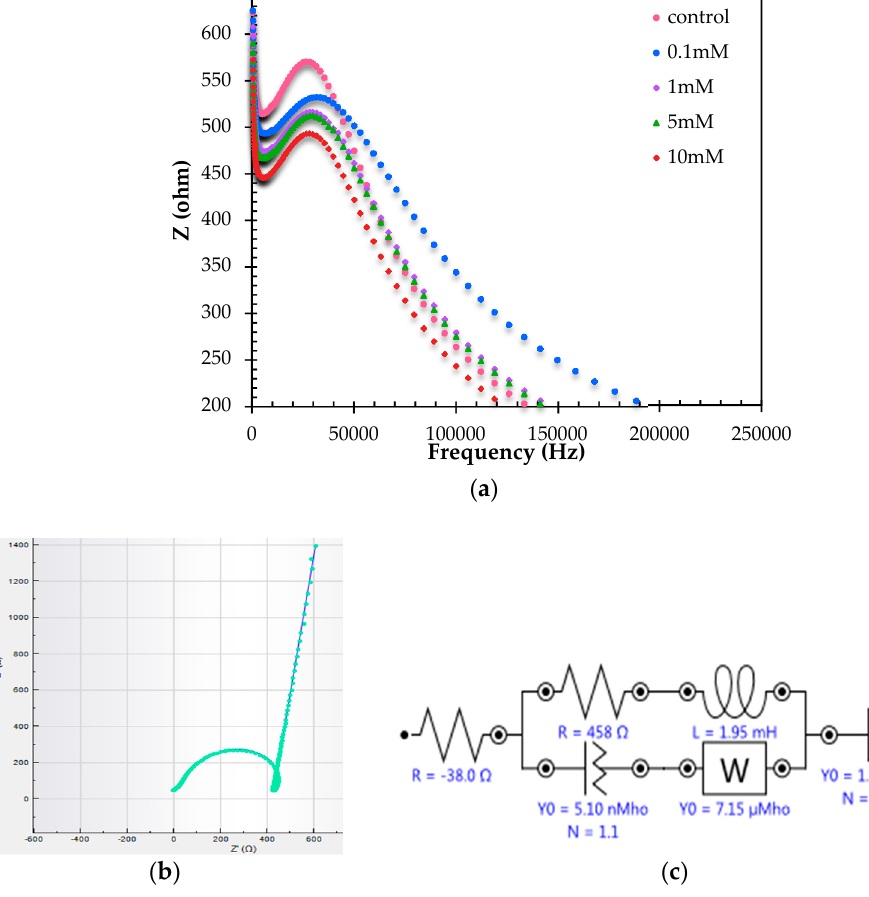
Figure 7. The ( a ) Bode modulus plot for the real milk sample at 33.5 kHz and ( b ) Nyquist plot of the real and ( c ) fitted equivalent circuit to represent the impedance biosensor of the Hb/TiAu-APTS/SPE biosensor with χ 2 ≤ 0.1. Table 2. Recovery of the milk sample for the Hb/TiAu-APTS biosensor in H 2 O 2 detection ( n = 3) with RSD = 6%.